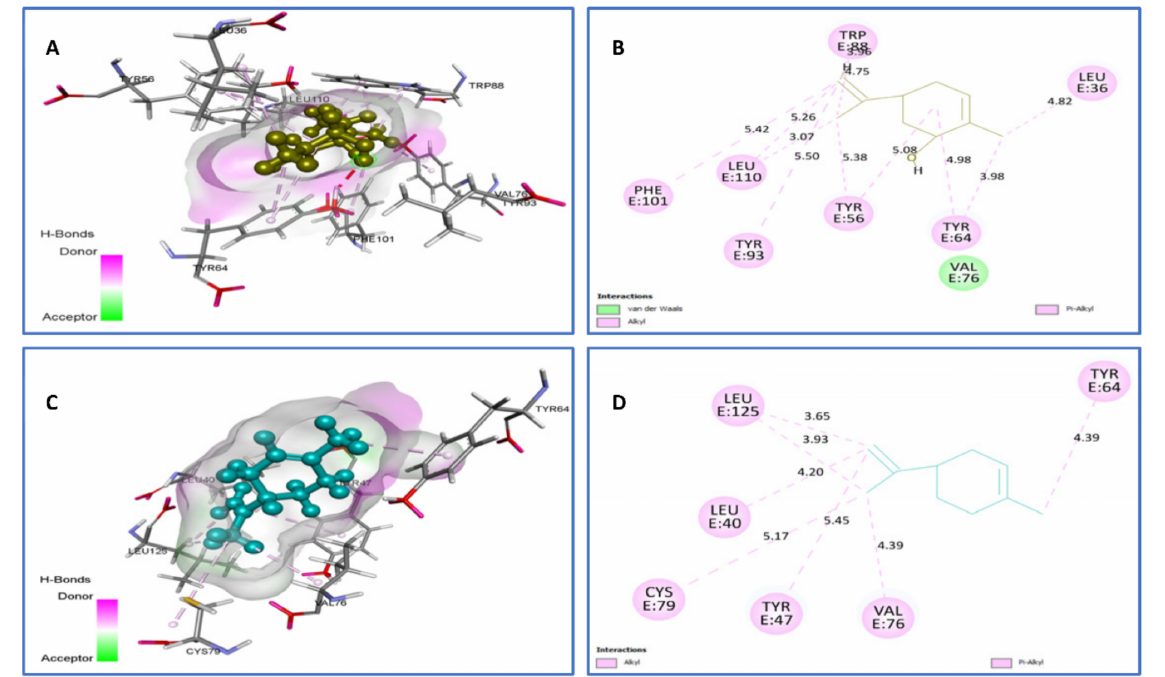
Figure 8. Two-dimensional (2D) and three-dimensional (3D) residual interactions network of trans - carveol ( A , B ) and limonene ( C , D ) with the active site of LasR enzyme (PDB ID, 2UV0).